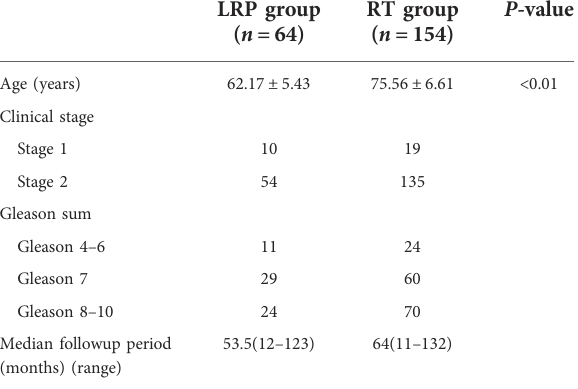
TABLE 1 Demographic data.